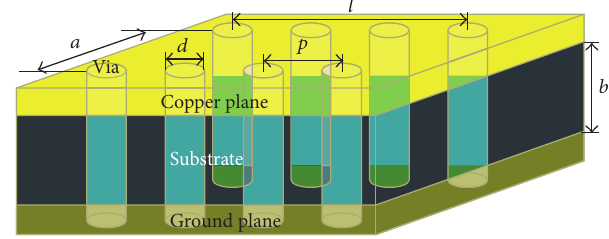
Figure 1: The 3D view of an SIW.